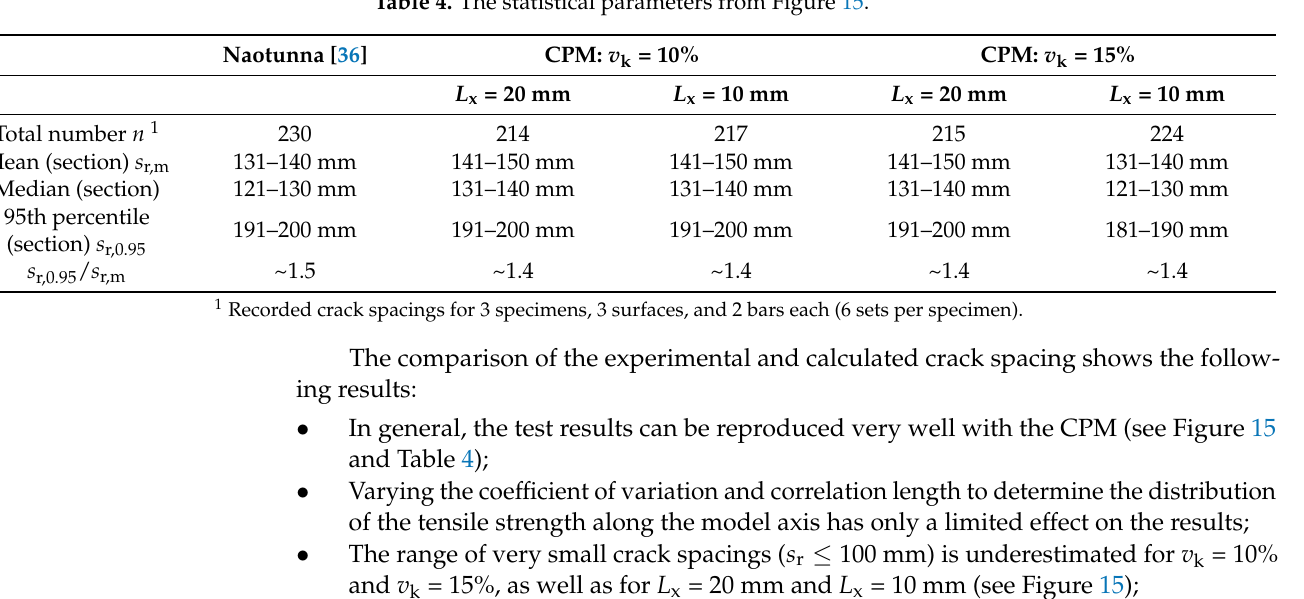
Figure 15. Distribution of experimental and calculated crack spacings in the test conducted by Naotunna [36]: ( a ) v k = 10%; ( b ) v k = 15%. Table 4. The statistical parameters from Figure 15.